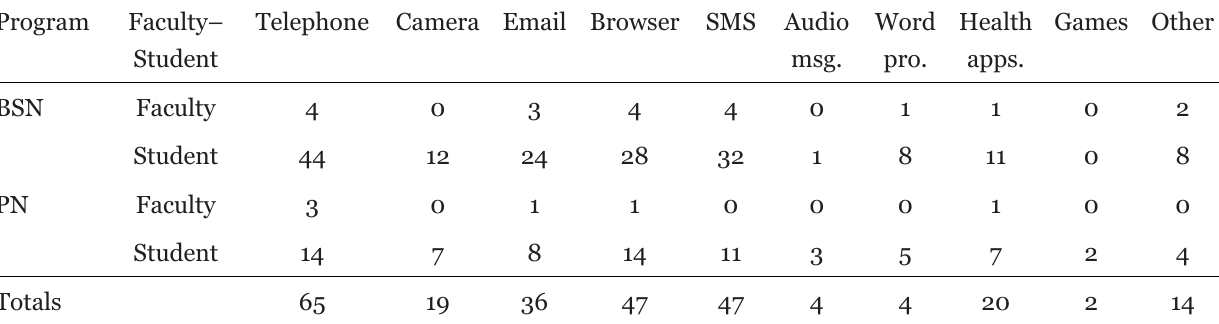
Mobile Features Used in Nursing Education by